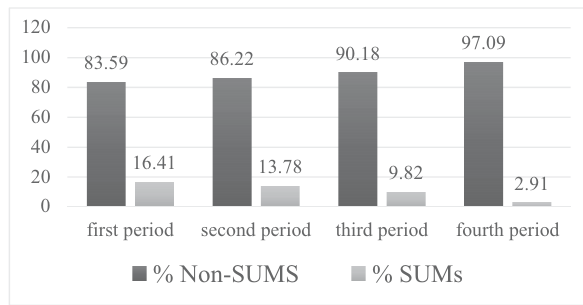
Figure 1: The inverse relation between SUMs and non - SUMs along the four time